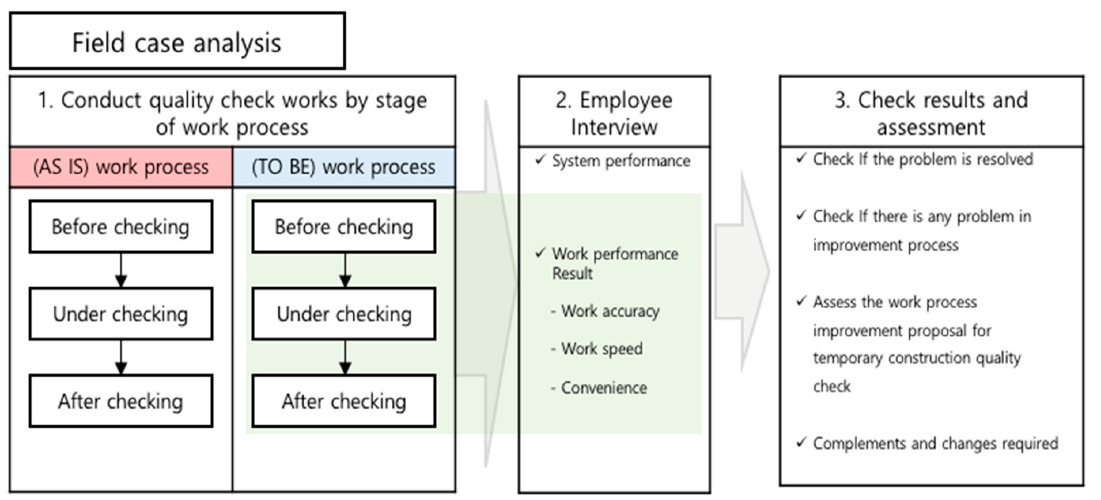
Figure 18. Evaluation process using a sample project.